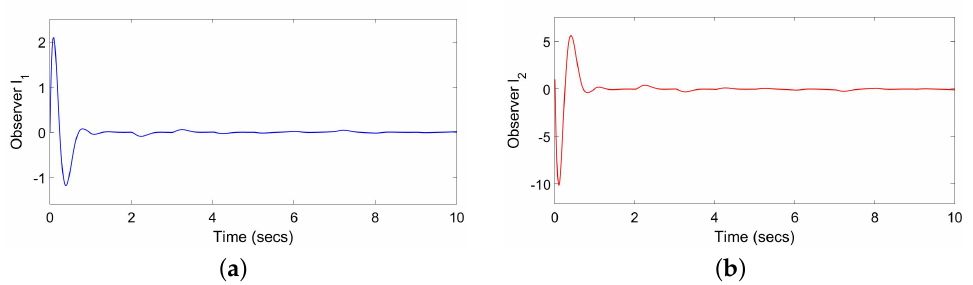
Figure 7. ( a ) Observer l 1 without probabilistic gain controller; ( b ) observer l 2 without probabilistic gain controller.